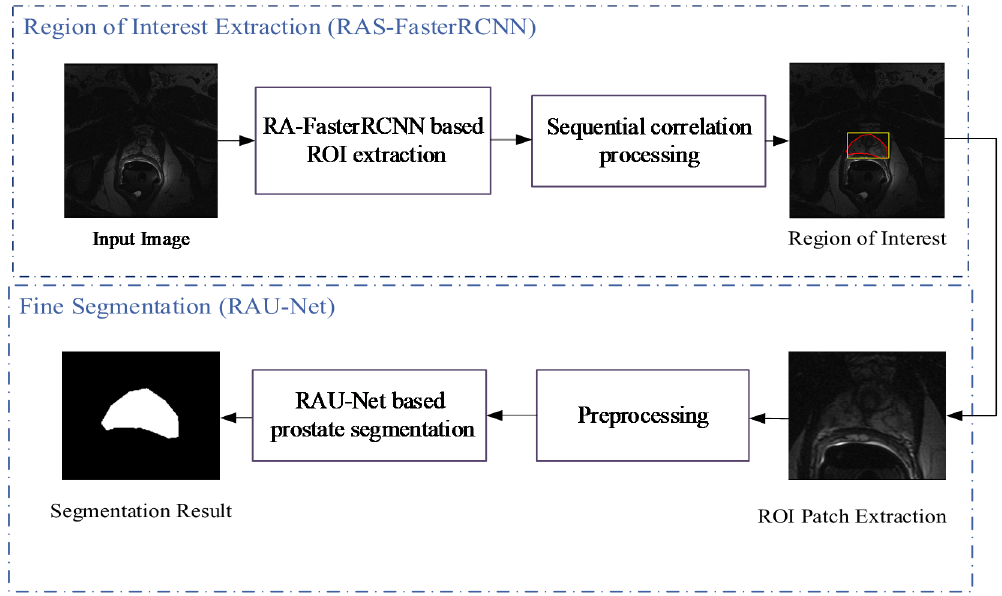
Figure 3. Flowchart of the proposed algorithm CDA-Net.